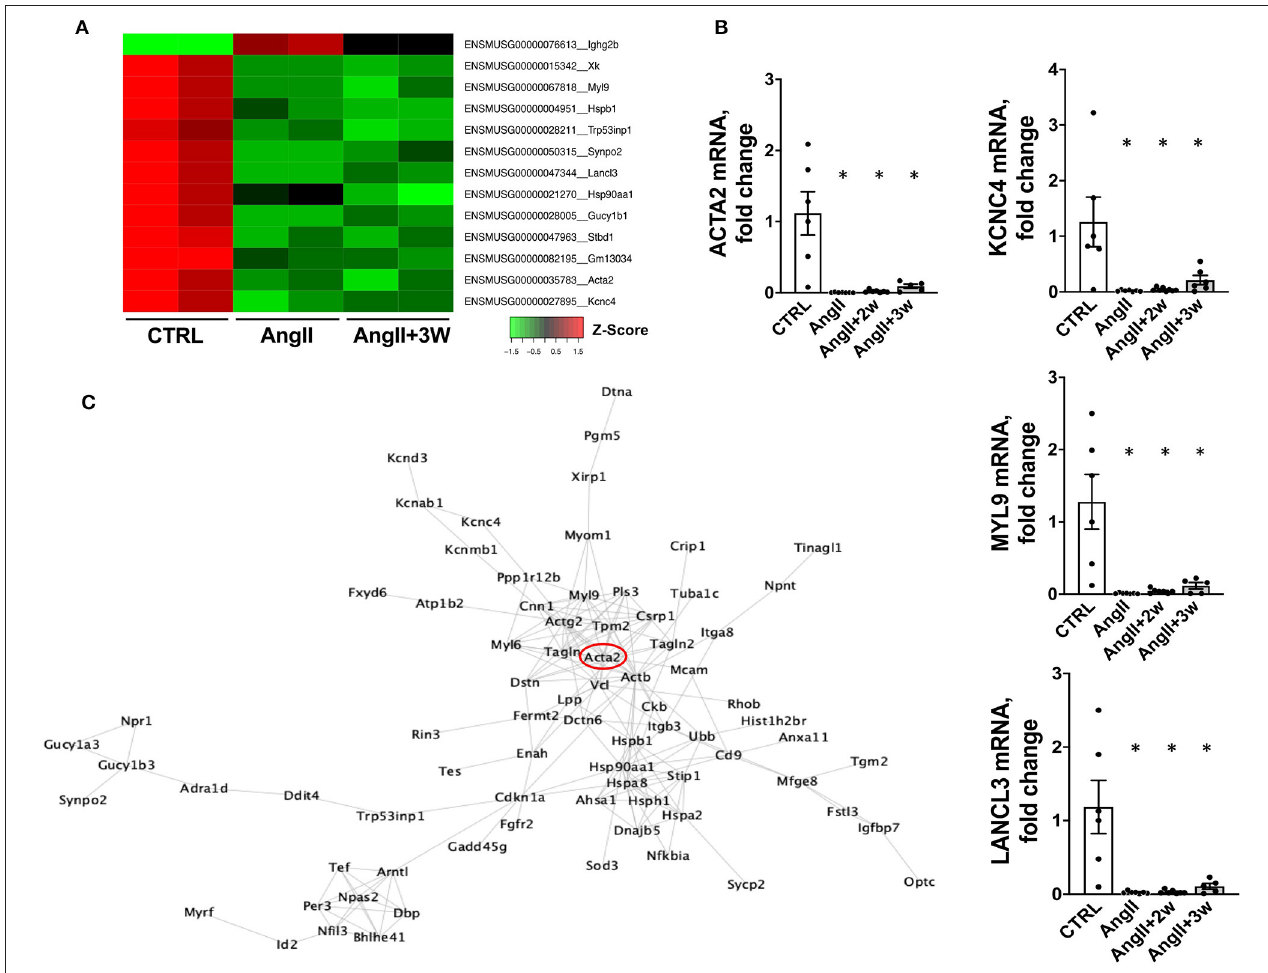
FIGURE 4 | Common downregulation of specific genes in aortic tissue from AngII and “memory model” and corresponding interactome mapping. (A) HeatMap representing expression level (Z-score) of the 13 identified commonly modulated transcripts in AngII + 3W and AngII vs. CTRL conditions. (B) RT qPCR on a replication group of mice confirming RNA seq expression data on selected genes: Lancl3 , Kcnc4 , Myl9 , and Acta2 , n = 25; * p < 0,05, one way ANOVA followed by Holm’s-Sidak comparison test. (C) Protein–protein interaction network corresponding to differentially expressed genes in aorta in the “memory” condition ( AngII + 3w ) vs. CTRL . To build a comprehensive picture, genes with FDR up to < 0,1 were included. Based on Cytoscape String Network